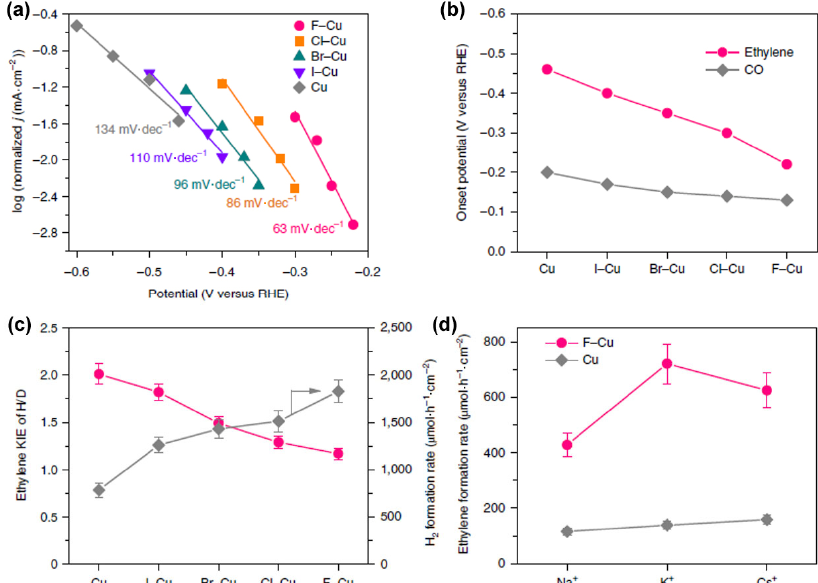
Figure 5 Functioning mechanism of halogen on X-Cu catalysts. (a) Tafel plots for the CO 2 RR to C 2 H 4 . (b) Onset potentials for CO and C 2 H 4 . (c) KIE of H/D in